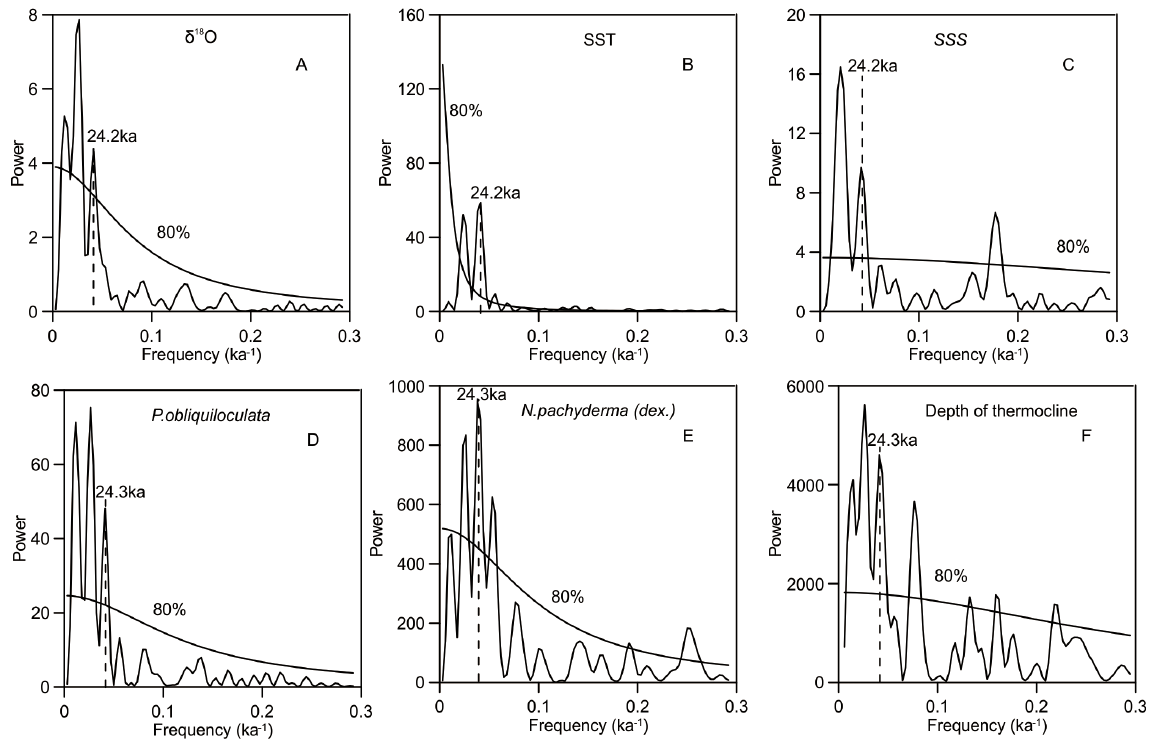
Figure 10. Power spectrum of the δ 18 O, SST (sea surface temperature), SSS (sea surface salinity), depth of the thermocline and the abun- dances of P.obliquiloculata and N.pachyderma (dex.) time series. All proxies show a common frequency during the precession cycles (near